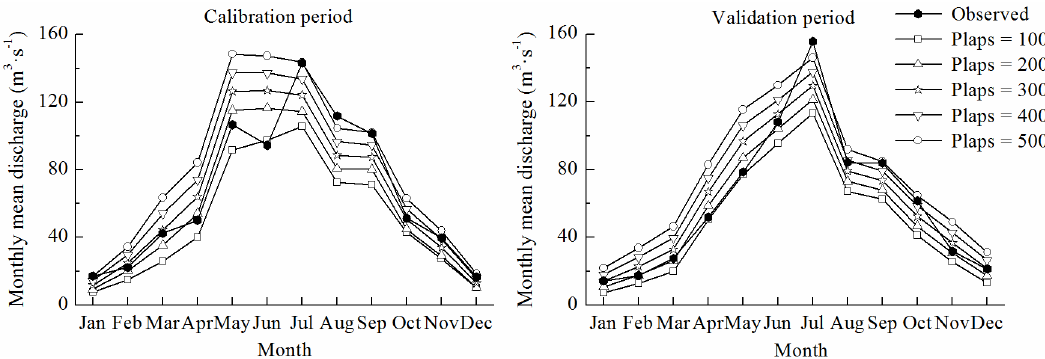
Figure 3. Observed and simulated monthly mean discharges impacted by variations in Plaps in the calibration and validation periods.